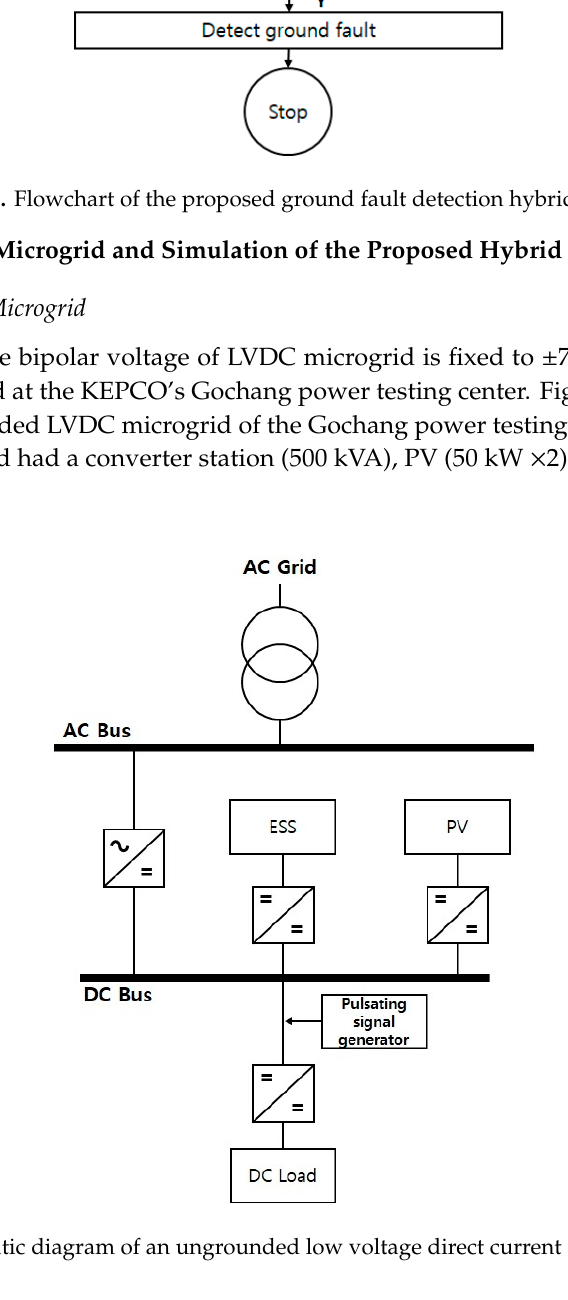
Figure 4. Schematic diagram of an ungrounded low voltage direct current (LVDC) microgrid.